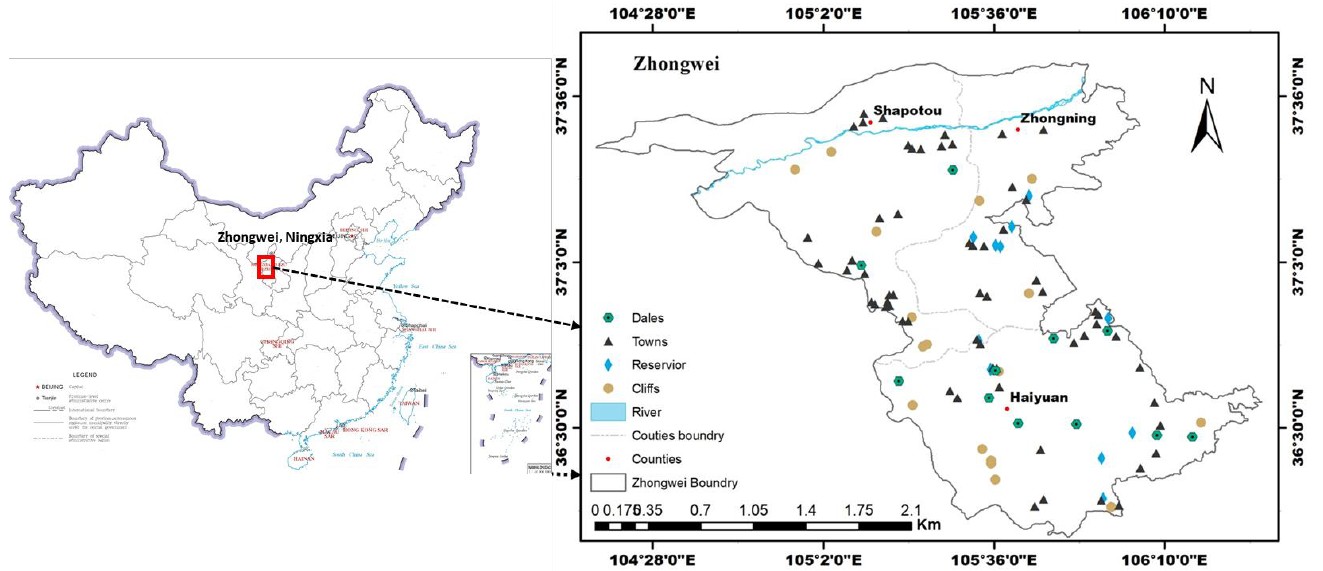
Figure 1. Location of the study area and descriptive features, Zhongwei China.